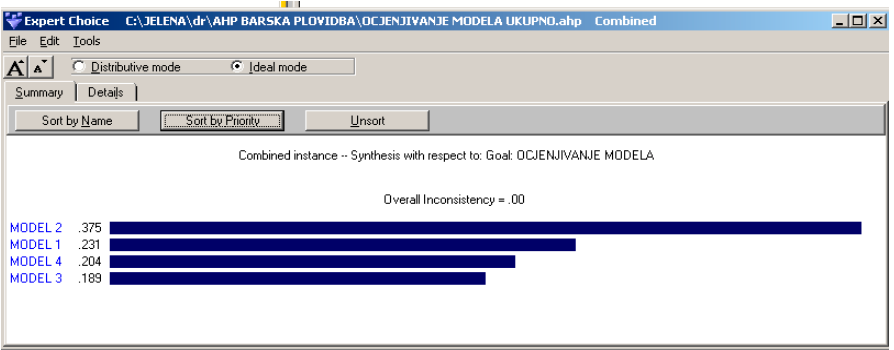
Figure 8. Results of evaluation of the BSC models obtained by Team 2 using the AHP method.